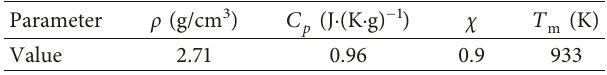
Table 3: Values of material parameters for 6005 Al alloy. Parameter